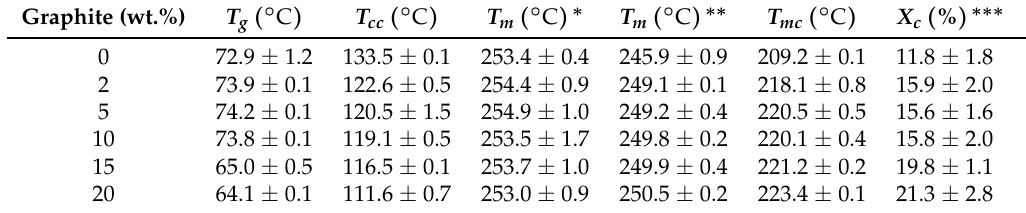
Table 1. DSC data for PET/graphite micro-composites.